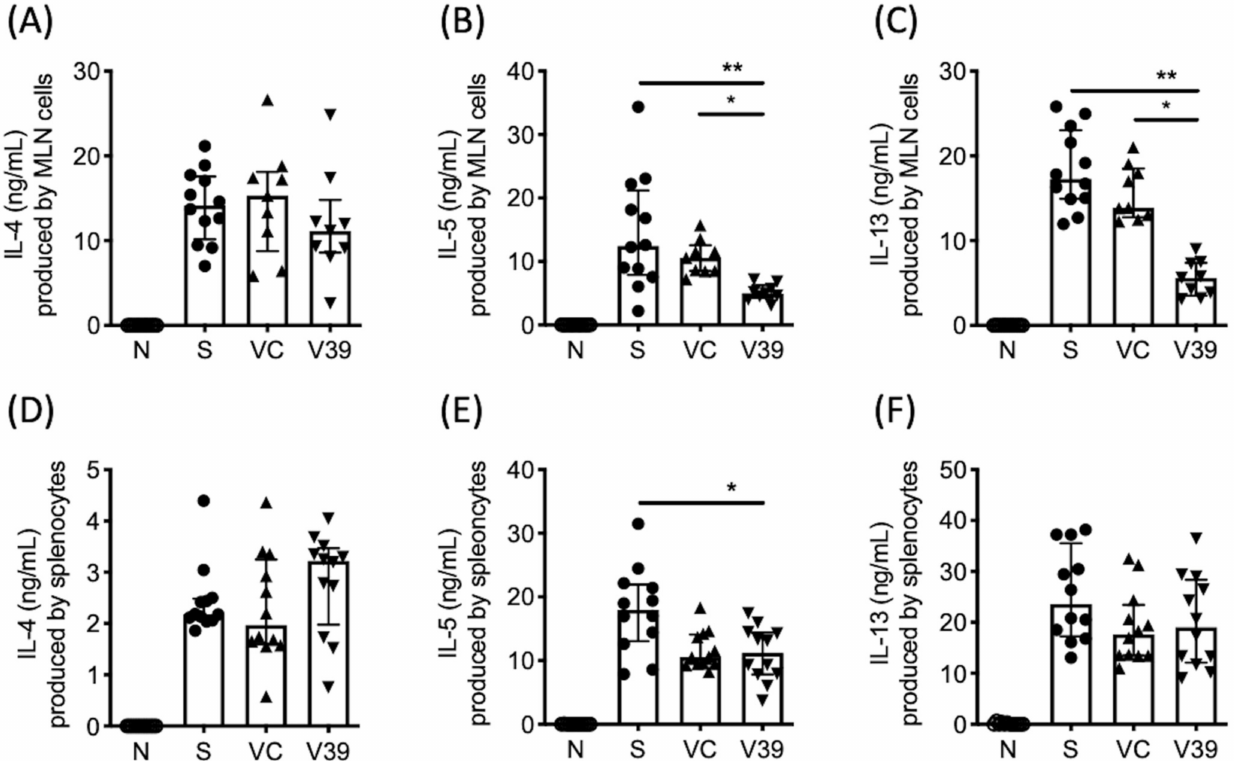
Figure 5. Cytokine levels in the culture supernatants of OVA-stimulated cells of mediastinal lymph nodes (MLNs) and spleens. Lymphocytes from ( A – C ) MLN or ( D – F ) spleen were stimulated with 100 µ g/mL OVA for 6 days. Cytokine levels were measured by ELISA. Data are presented as median with interquartile range (* p < 0.05, ** p < 0.01 in the comparison of V39 with S or